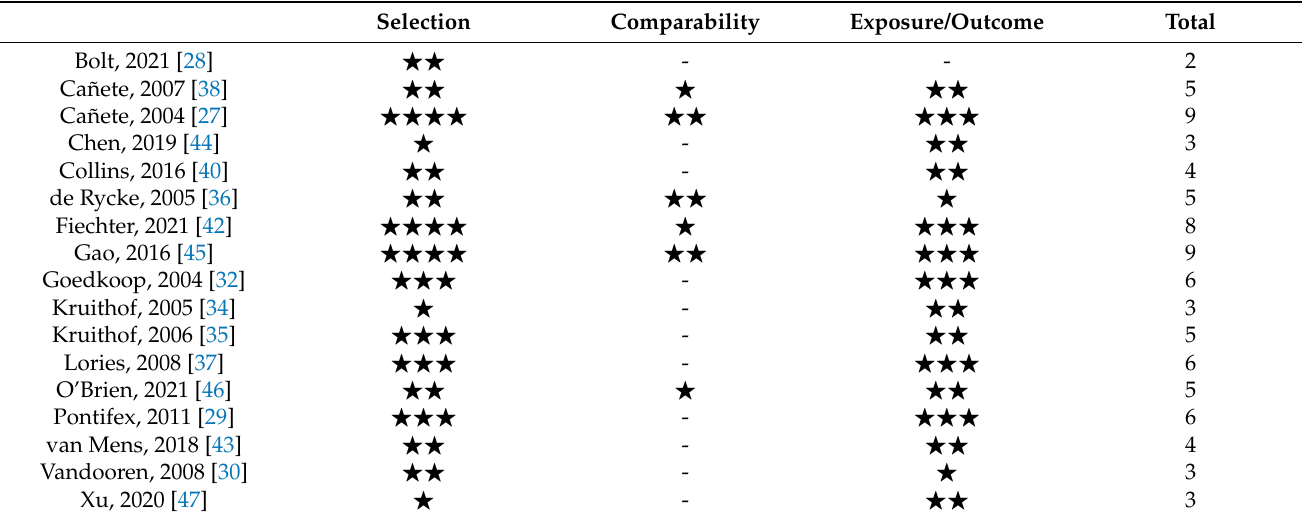
Table 5. Cochrane RoB 2 for risk of bias assessment for randomized controlled trials [21]. Green circle with cross indicates low risk of bias. Yellow circle with question mark indicates some concerns about risk of bias. Red circle indicates high risk of bias. Abbreviations: RoB: risk of bias.